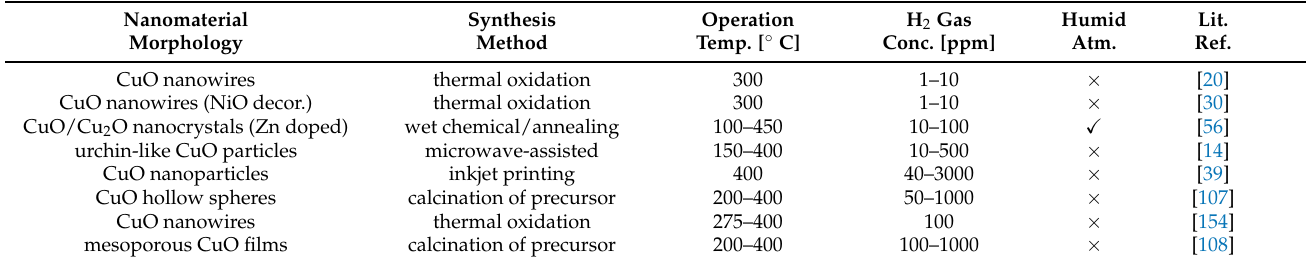
Table 4. A summary of sensing nitrogen oxide H 2 with copper oxide-based